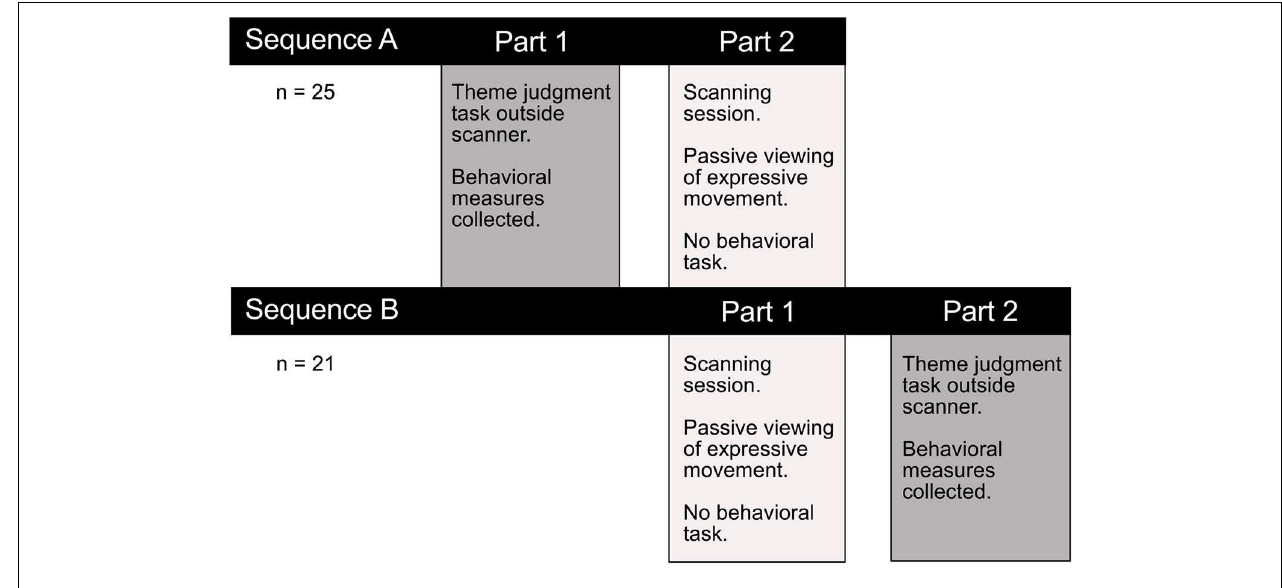
FIGURE 2 | Experimental testing procedure. Participants completed a thematic interpretation task outside the scanner, either before or after the imaging session. Performance on this task allowed us to test whether there was a difference in how readily observers interpreted the intended meaning